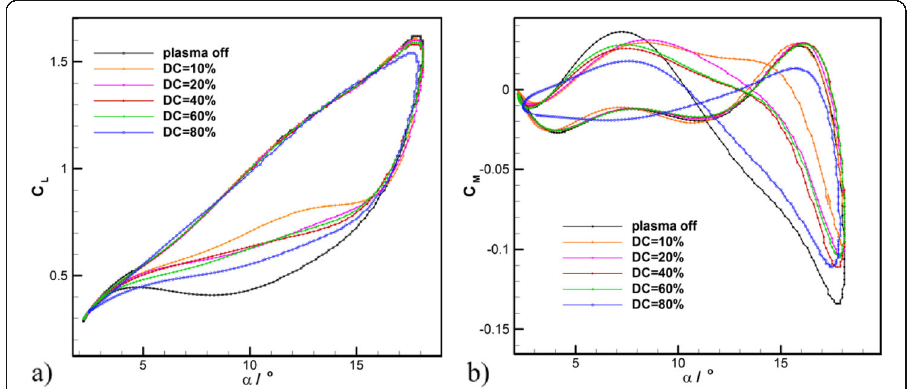
Fig. 6 Dependence of C L and C M on duty cycle of the unsteady